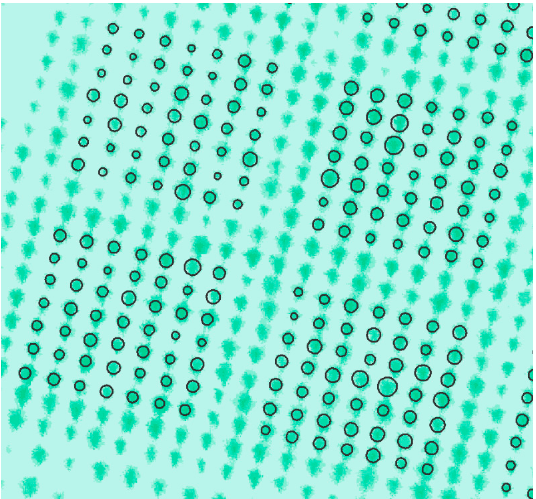
Figure 3. Image of the ULS point cloud at Rangipo overlaid with the annotations that were assigned to each tree in the trial. each tree in the